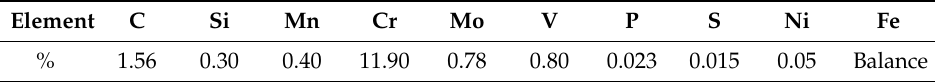
Table 1. Chemical composition of AISI D2 Steel.